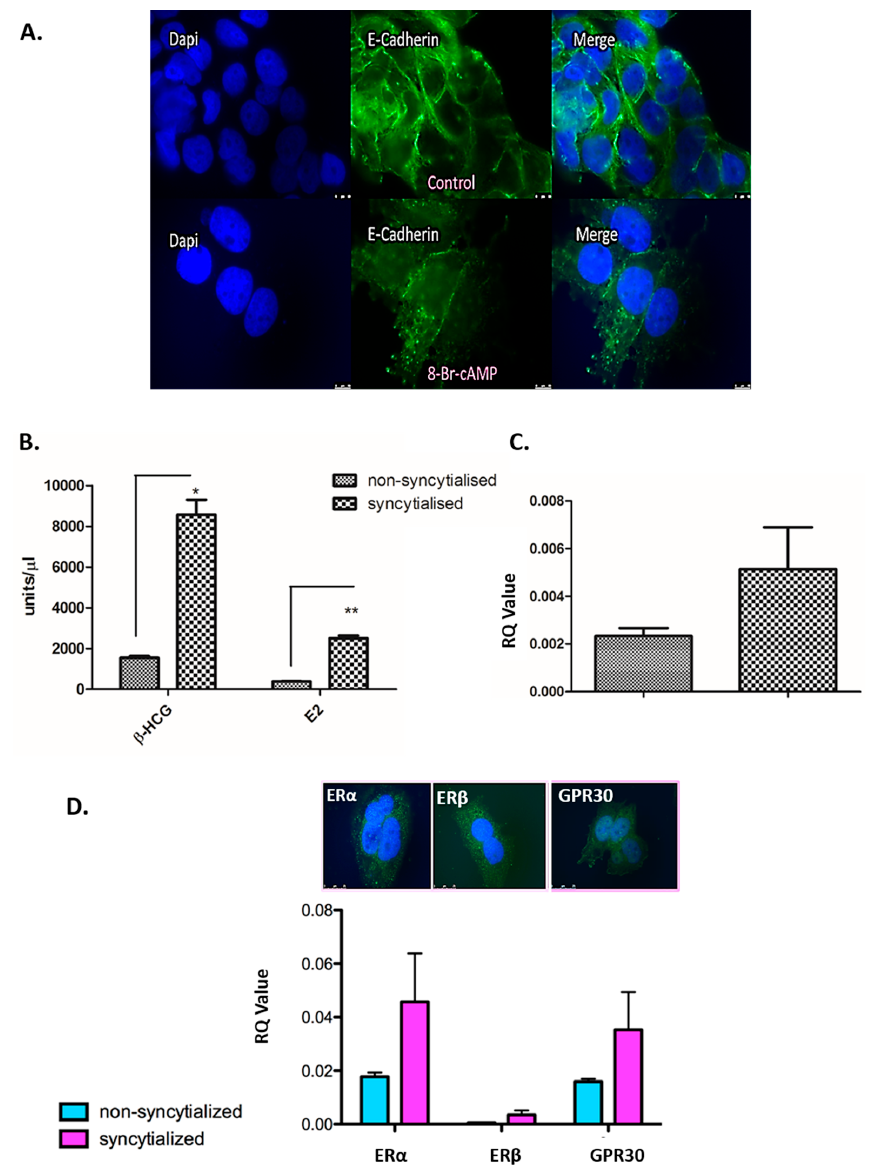
Figure 5. ( A ) Immunofluorescent staining of E-Cadherin (a marker of cell fusion) in BeWo cells treated with 8-bromo-cAMP (8-Br-cAMP) in order to syncytialise. Green: E-Cadherin; blue: DAPI nuclear stain (a blue fluorescent dye used to detect nuclei in fluorescence microscopy). Cells depicted in the bottom row have been treated with 8-Br-cAMP for 72 h, while cells depicted in the top row have not (controls). As BeWo cells treated with 8-Br-cAMP fuse to become syncytia (amorphous and multinucleated cells), cell walls break down and lose E-Cadherin. ( B ) Secretion of estradiol (E2) and β -human chorionic gonadotropin ( β -hCG) in conditioned media of nonsyncytialised and syncytialised BeWo cells grown for 24 h. Expression of both β -hCG and E2 was significantly upregulated in syncytialised BeWo cells ( p = 0.0108 and p = 0.0042, respectively) compared to nonsyncytialised BeWo cells. ( C ) Expression of syncytin-2 (a marker of syncytialisation) in nonsyncytialised and syncytialised BeWo cells, showing a more than 2-fold increase in syncytin-2 in the latter (relative quantities are levels of the gene of interest in relation to quantities of housekeeping gene TOP1). ( D ) All three estrogen receptors (ER α , ER β , and GPR30) were also present in syncytialised BeWo cells compared to nonsyncytialised BeWo cells. ( Insert in D ). Immunostaining of syncytialised BeWo cells for estrogen receptors; merged images. Green: receptor; blue: DAPI nuclear stain. ER α and ER β show a more nuclear staining pattern, whereas GPR30 staining is more focused around the cell